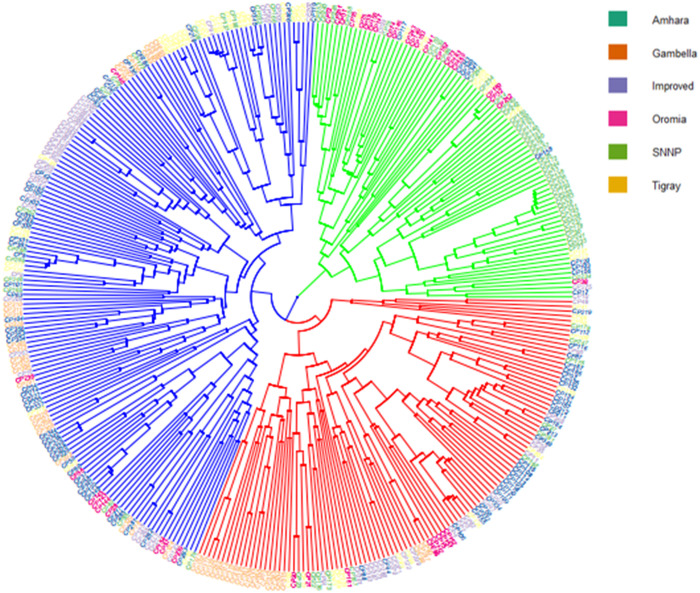
UPGMA dendrogram showing the genetic relationships among cowpea collections grouped into three distinct clusters (cluster 1 = red, cluster 2 = green and cluster 3 = blue).